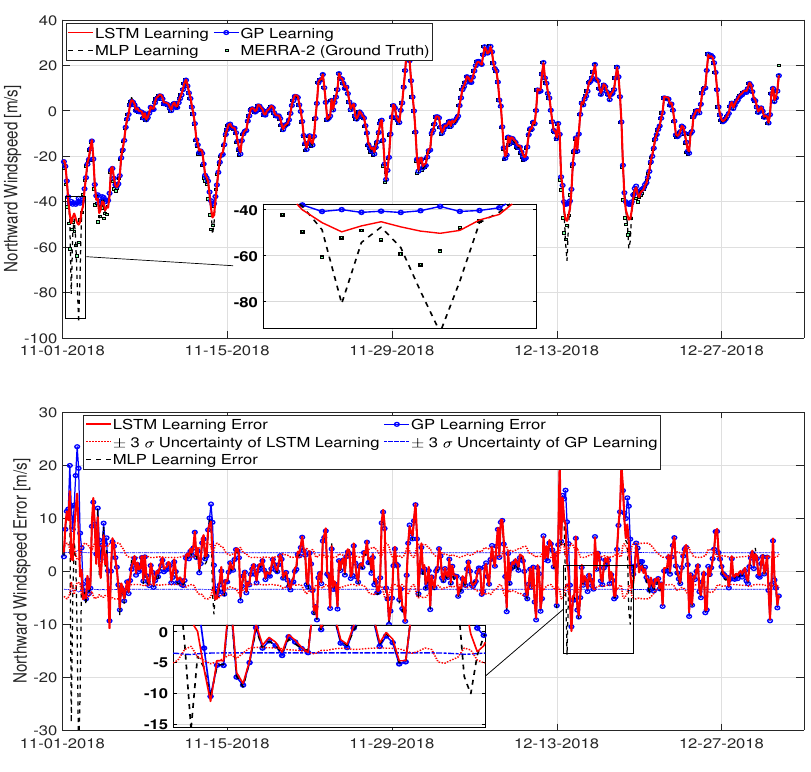
Figure 5. Performance evaluation of the machine learning prediction models to the validation phase datasets (2018